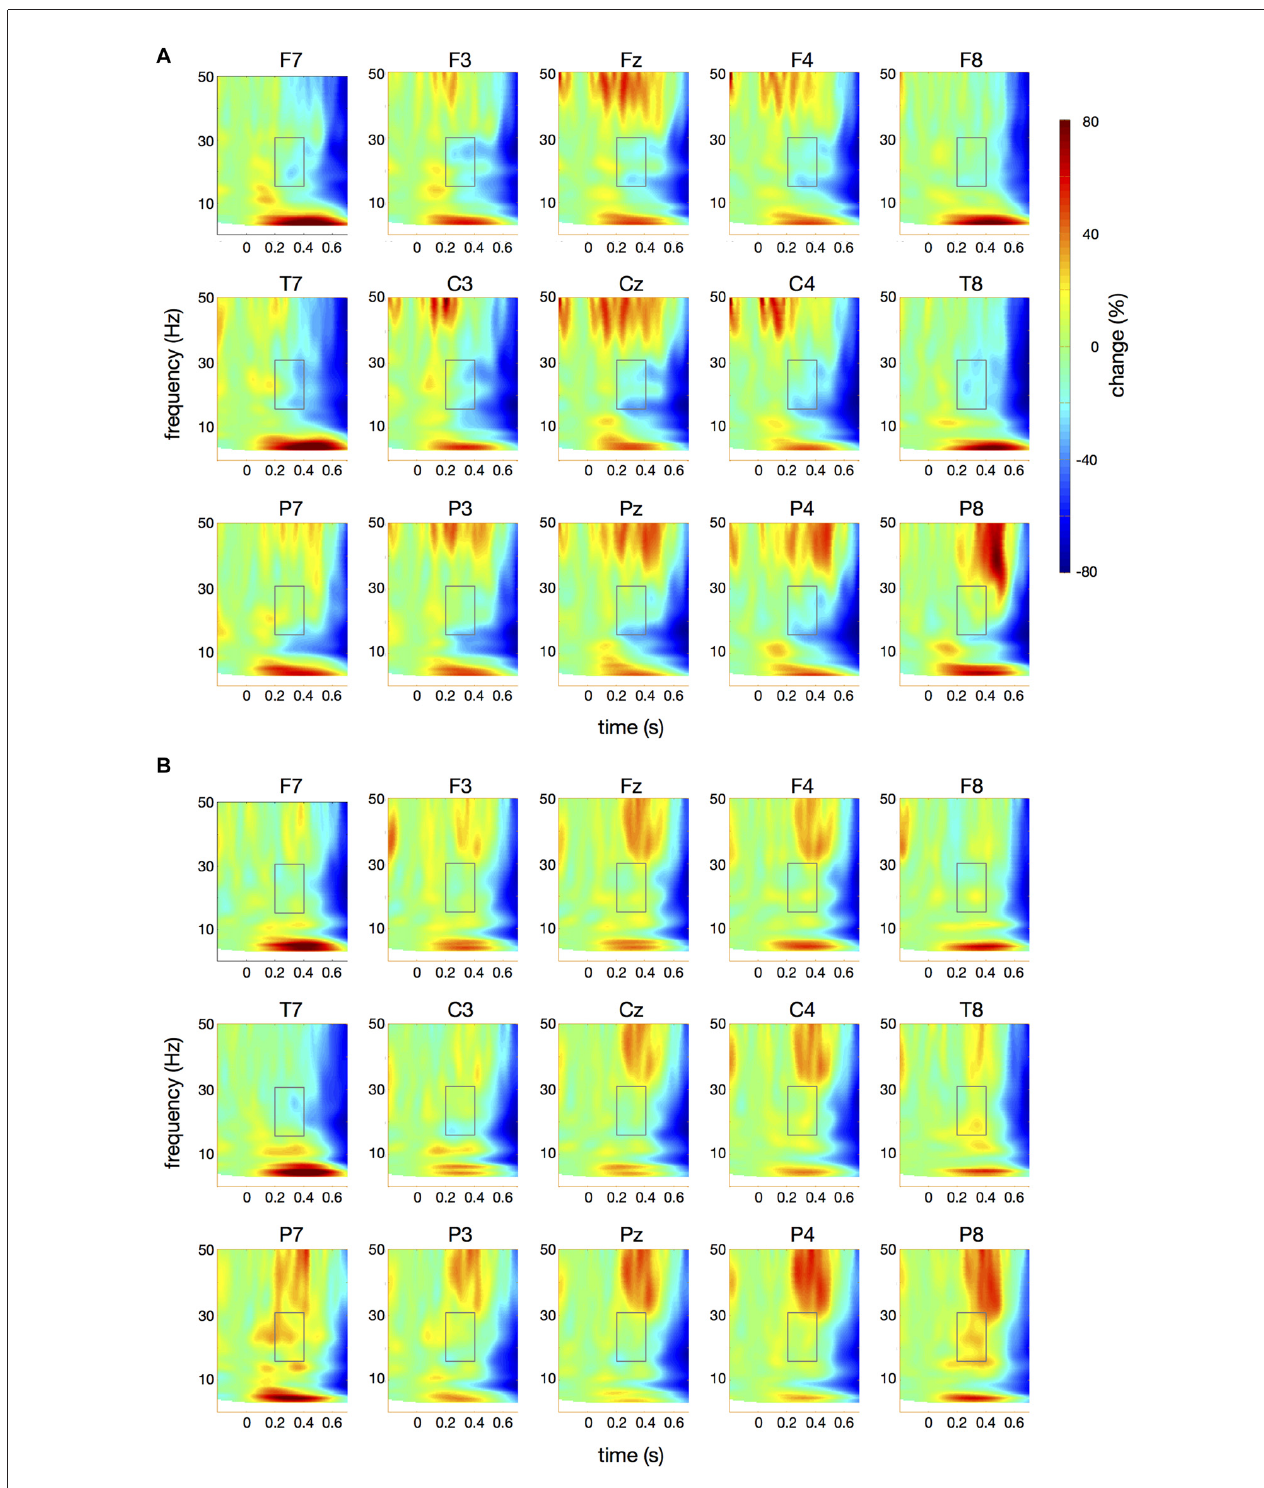
FIGURE 4 | Time-frequency spectra for the papapa condition. The figure represents averaged changes in spectral power relative to a baseline period of − 100 ms to 0 ms during the preparation for speech production. Time (in seconds) is shown on the x -axis; 0 s is the onset of the visual cue ( papapa ). Frequency (1–50 Hz) is shown on the y -axis. Time-frequency spectra are shown for controls (A) and patients (B) . The boxes represent the frequency range (16–31 Hz) and time window (200–400 ms) of the ANOVA.